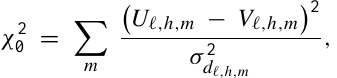
Fig. 6. χ 2 test on differences between SCIAMACHY monthly mean zonal mean ozone profiles and MLS, SABER, SAGE, HALOE and ACE-FTS data. Purple patterns indicate significant differences which cannot be explained by random errors.